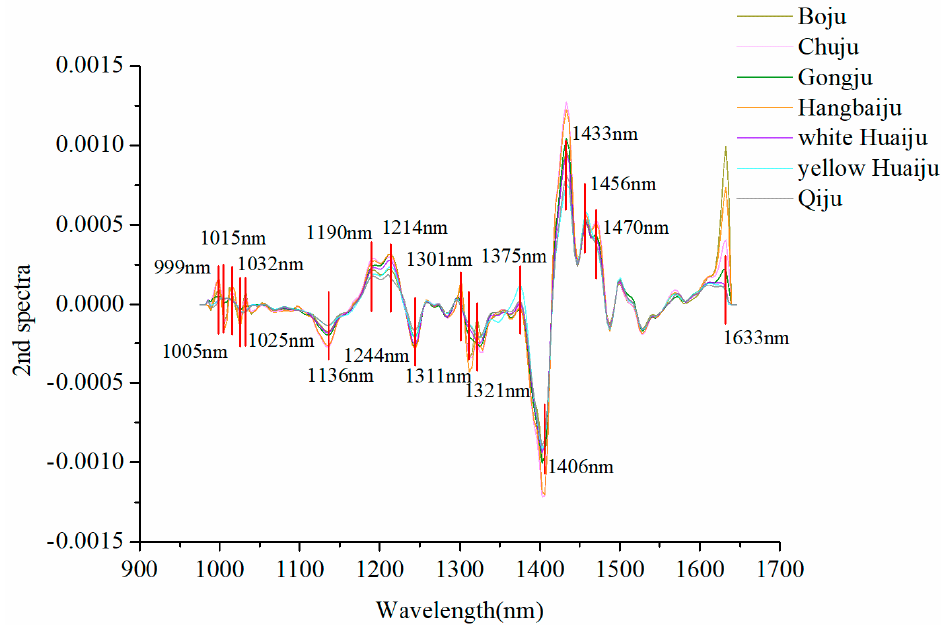
Figure 3. The 2nd derivative spectra and the selected optimal wavelengths.